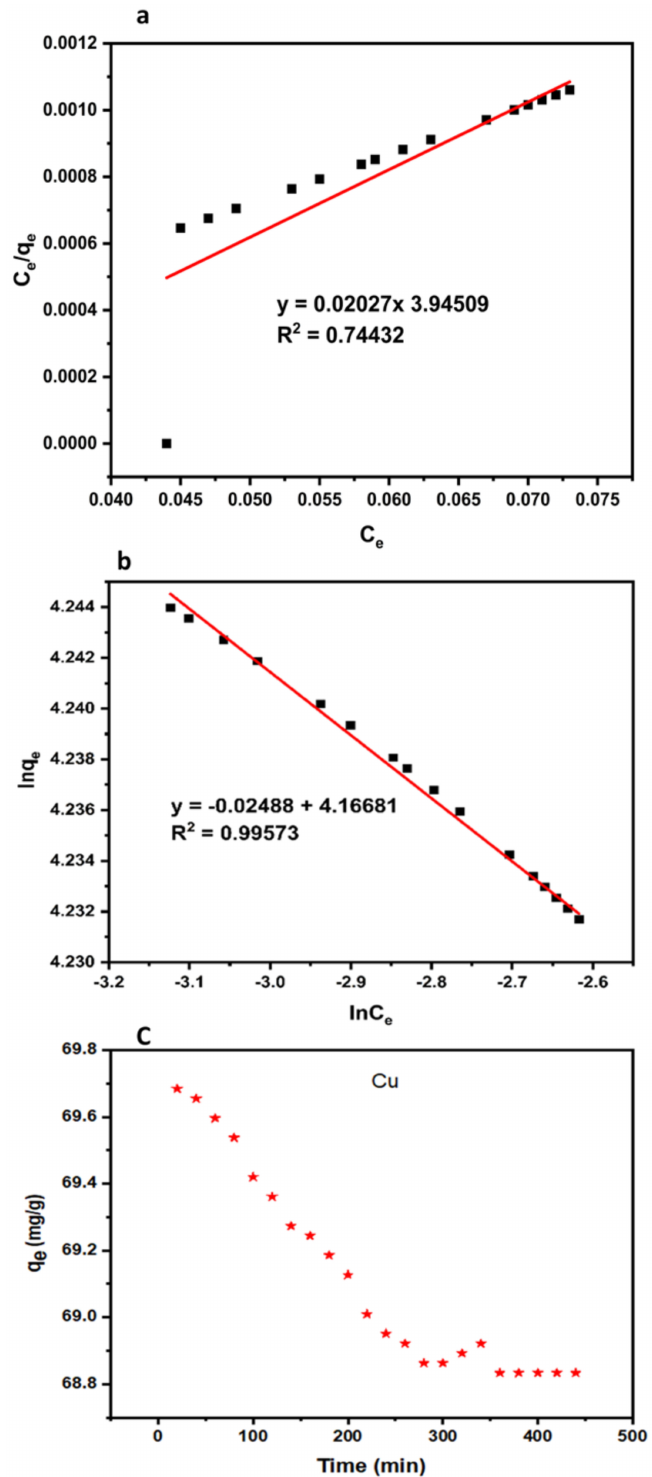
Figure 7. Langmuir ( a ), Freundlich isotherm, ( b ) and copper adsorption capacity ( c ) into hollow fiber membrane at pH 10, time 440 min, and initial copper concentration 2.42